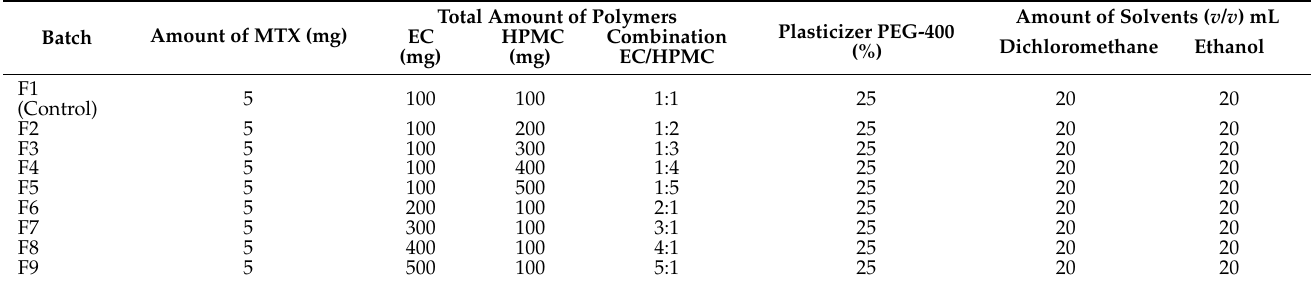
Table 1. Composition of methotrexate transdermal